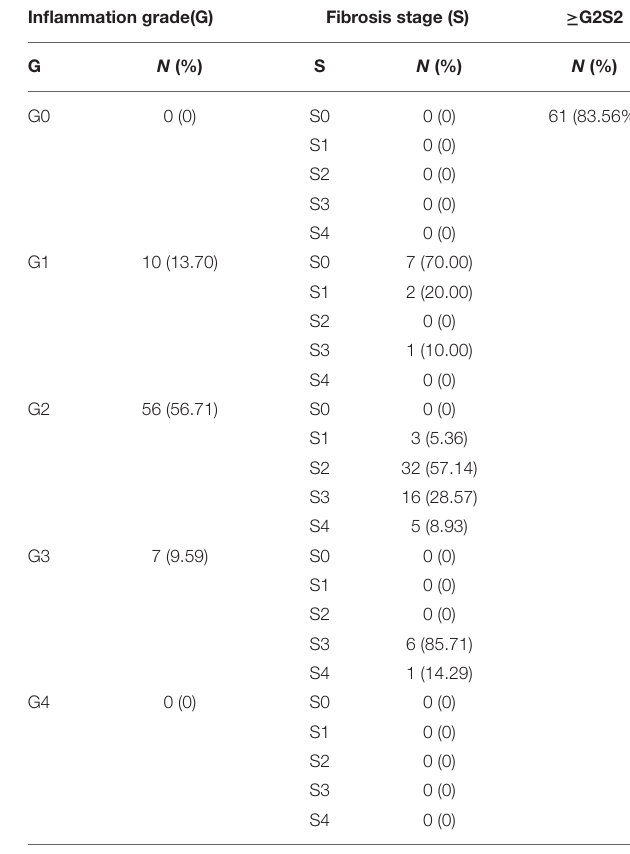
TABLE 2 | Inflammation grade and fibrosis stageamong73 HBV-infected patients with HBeAg-negativity and a normal ALT level. Inflammation grade(G) Fibrosis stage